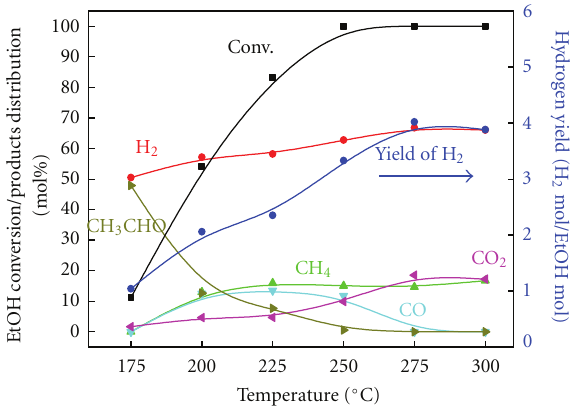
Figure 1: Catalytic performance in the SRE reaction over PtRuMg/ZrO 2